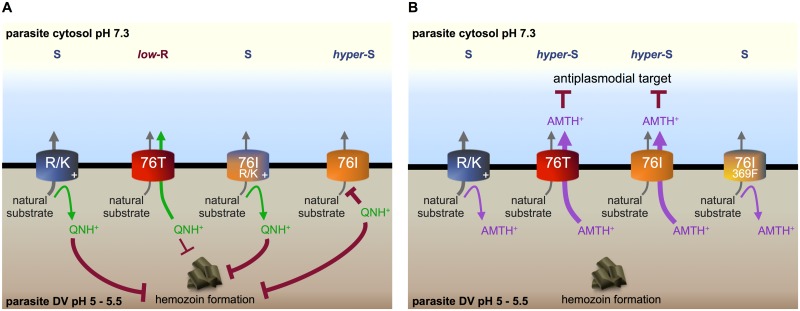
Molecular mechanisms for the drug hypersensitivities induced by PfCRT isoforms in the malaria parasite.(A) The variants of PfCRTK1 that contain 72R, 76K, 163R, 352K, or 352R (R/K) do not possess significant quinine (QN) transport activity. The drug would therefore remain in the parasite’s DV where it exerts an anti-hemozoin effect that kills the parasite, which is consistent with the QN-sensitive (S) status of the respective lines. PfCRTK1 (76T) is able to transport QN out of the DV and thereby imparts low-level resistance (low-R) to QN. By contrast, 76I-PfCRTK1 has an extremely high affinity for QN coupled with an extremely low maximum rate of transport. This causes QN to clog the binding site of 76I-PfCRTK1, thereby blocking the transport of the natural substrate. Hence, the QN-hypersensitivity (hyper-S) observed in 106/176I parasites results from QN exerting two killing effects—anti-hemozoin and anti-PfCRTCQR. The gain of a positively-charged residue at position 72 or 352 (76I R/K) prevents the interaction of the transporter with QN and returns the parasites to QN-sensitive status. (B) Amantadine (AMT) is a relatively poor inhibitor of both 76I-PfCRTK1 and 76I,369F-PfCRTK1, making it unlikely that the AMT-hypersensitivity of CQ-resistant parasites is due to an anti-PfCRTCQR effect. The isoforms of PfCRT from AMT-hypersensitive parasites (PfCRTK1 and 76I-PfCRTK1) have the ability to transport this weak-base drug out of the DV (where it accumulates) whereas those from AMT-sensitive parasites either do not possess significant AMT transport activity (e.g., 76K-PfCRTK1 and 163R,356V-PfCRTK1; R/K) or transport AMT with low affinity and low capacity (76I,369F-PfCRTK1). The data therefore converge on a scenario in which AMT exerts its main antimalarial activity in the cytosol and AMT-hypersensitivity arises from the redistribution of the drug from the DV into the cytosol via a PfCRTCQR variant (e.g., PfCRTK1 or 76I-PfCRTK1).